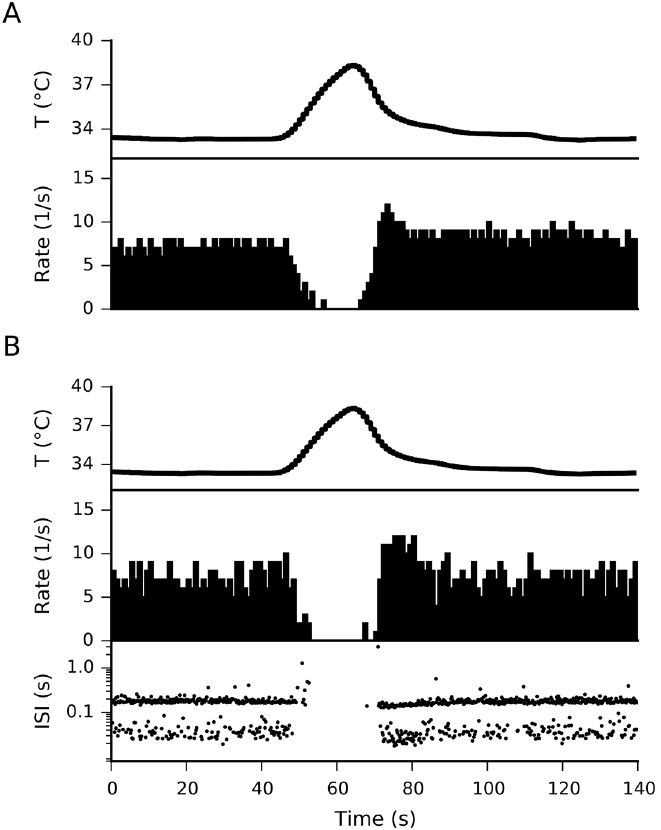
Fig 2. Dynamic response to heat. A. Temperature trace (top) and firing rate (bottom) in an experimental recording in mouse cornea. B. Our model subjected to the same temperature trace, showing the firing rate and ISIs obtained with parameter set